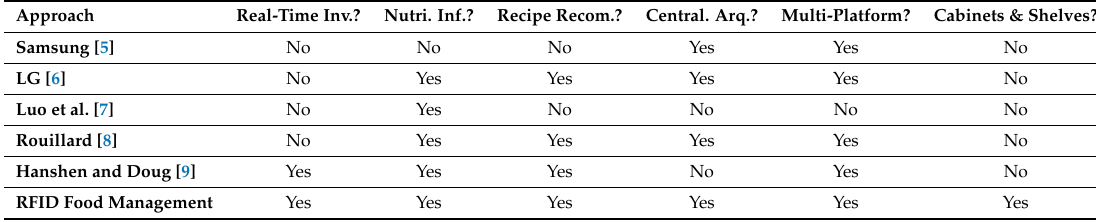
Table 1. The radio frequency identification (RFID) Food Management provides more advantages than other authors’